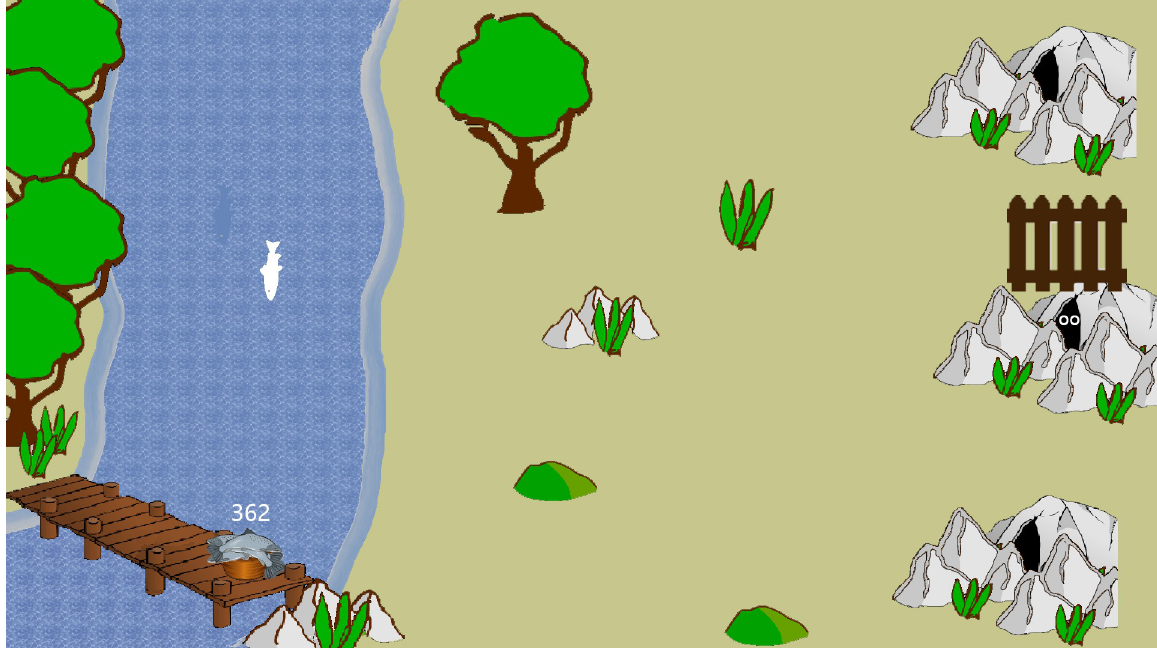
Fig 1. Visual stimuli used in the experiments. Note that not all stimuli shown were present at the same time during the actual experiment.